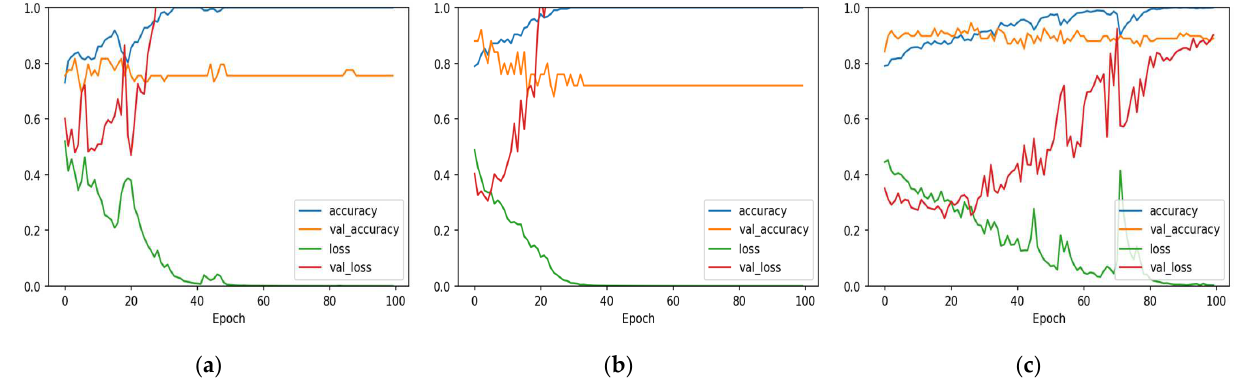
Figure 7. 1D-CNN model accuracy and loss with epochs. ( a ) Cleveland dataset; ( b ) Statlog dataset; ( c ) Comprehensive dataset.